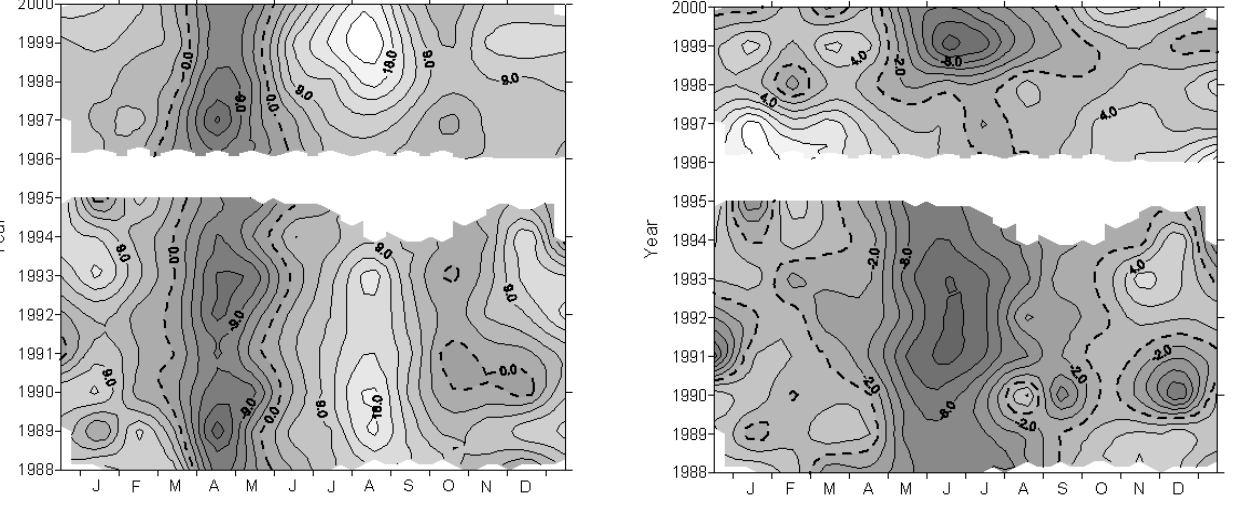
Fig. 5. As Fig. 4, except meridional